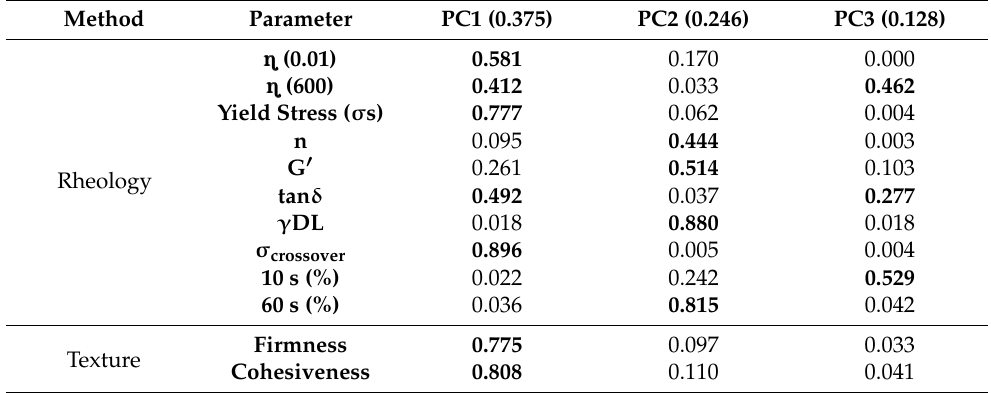
Table 13. Values of cos 2 for each parameter for the three axes of MFA (the significant values are in bold).